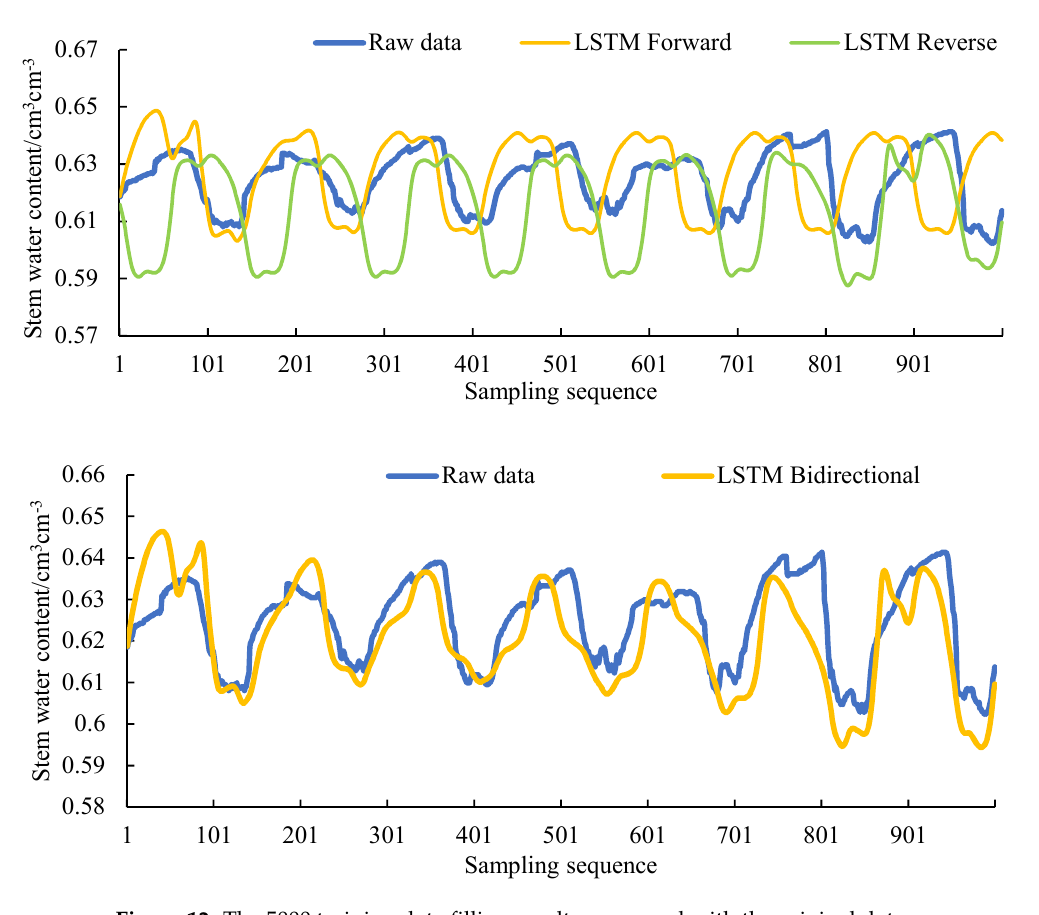
Table 8. Comparison of error statistical results.